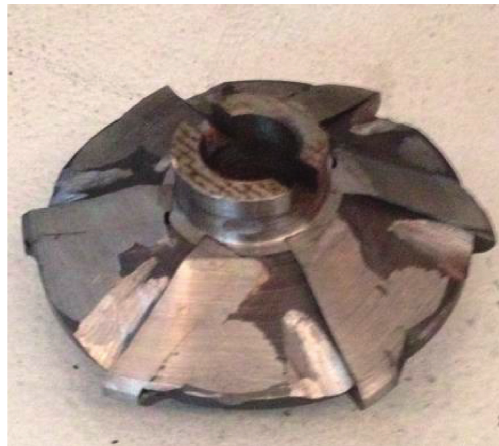
Figure 9: Picture of disc milling cutter.